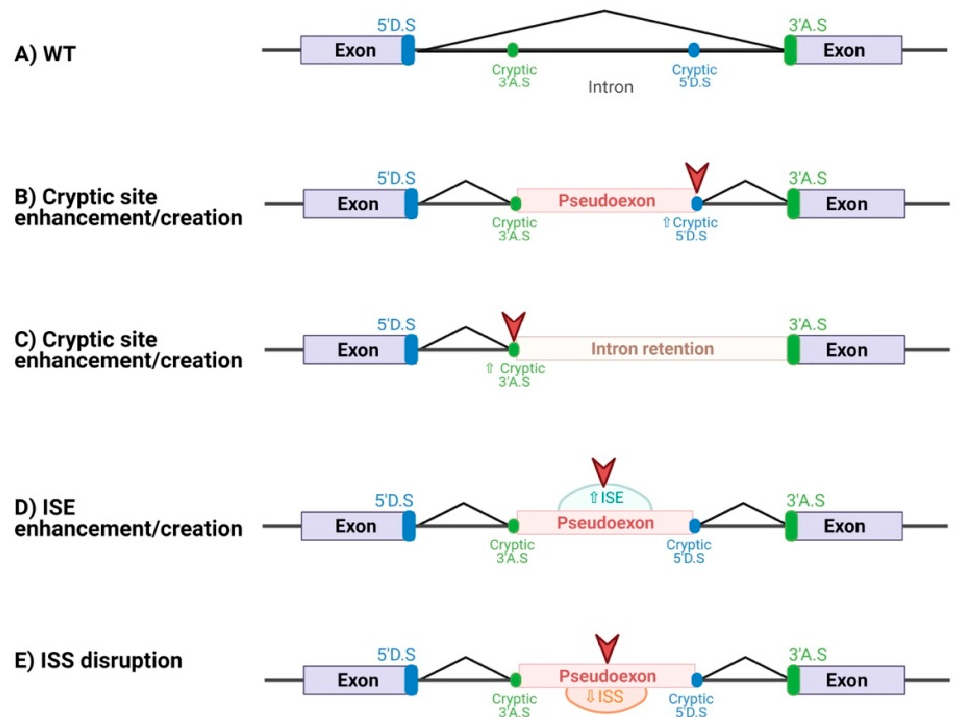
Figure 1. Splicing effects caused by deep intronic variants. ( A ) Normal splicing using natural splicing sites. ( B ) Deep intronic variant creating/enhancing a cryptic splice site, resulting in the inclusion of a pseudoexon by using a complementary cryptic site. ( C ) Intronic retention caused by a deep intronic variant that creates/enhances a cryptic site, which is used instead of the canonical splice site. ( D ) Deep intronic variant creating/enhancing an ISE, resulting in the inclusion of a cryptic exon using two cryptic splice sites. ( E ) Deep intronic variant disrupting an ISS, resulting in the inclusion of a cryptic exon using two cryptic splice sites.